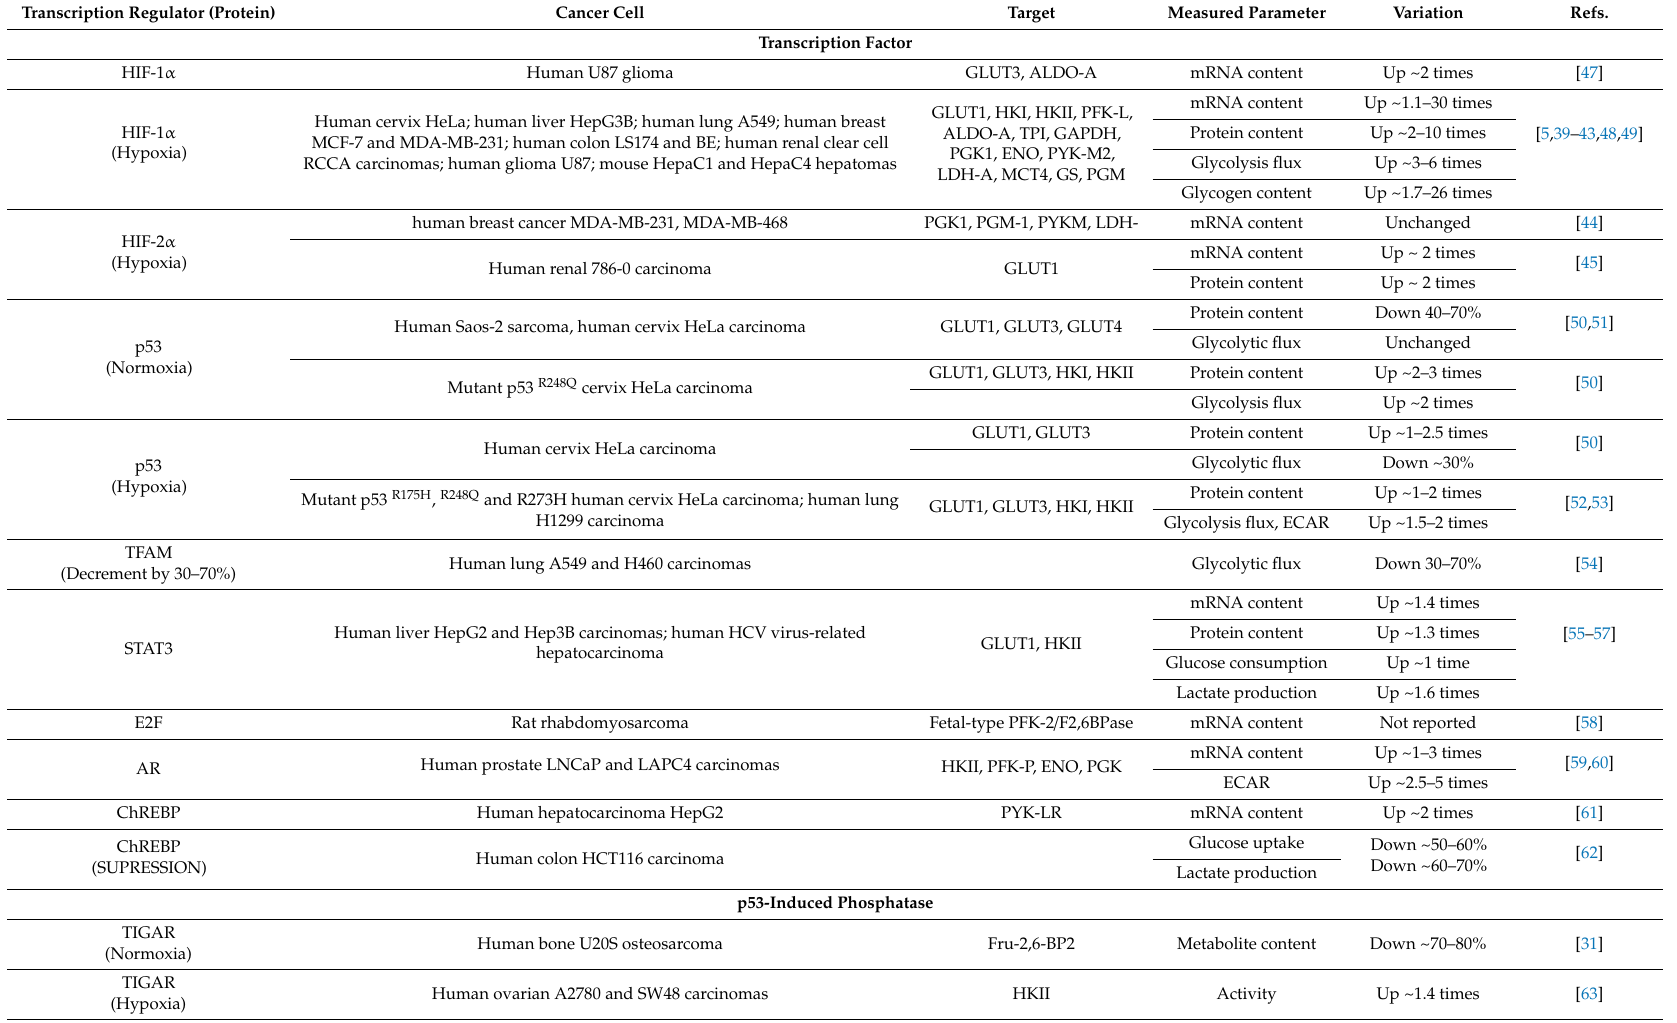
Table 2. Transcription regulators of cancer